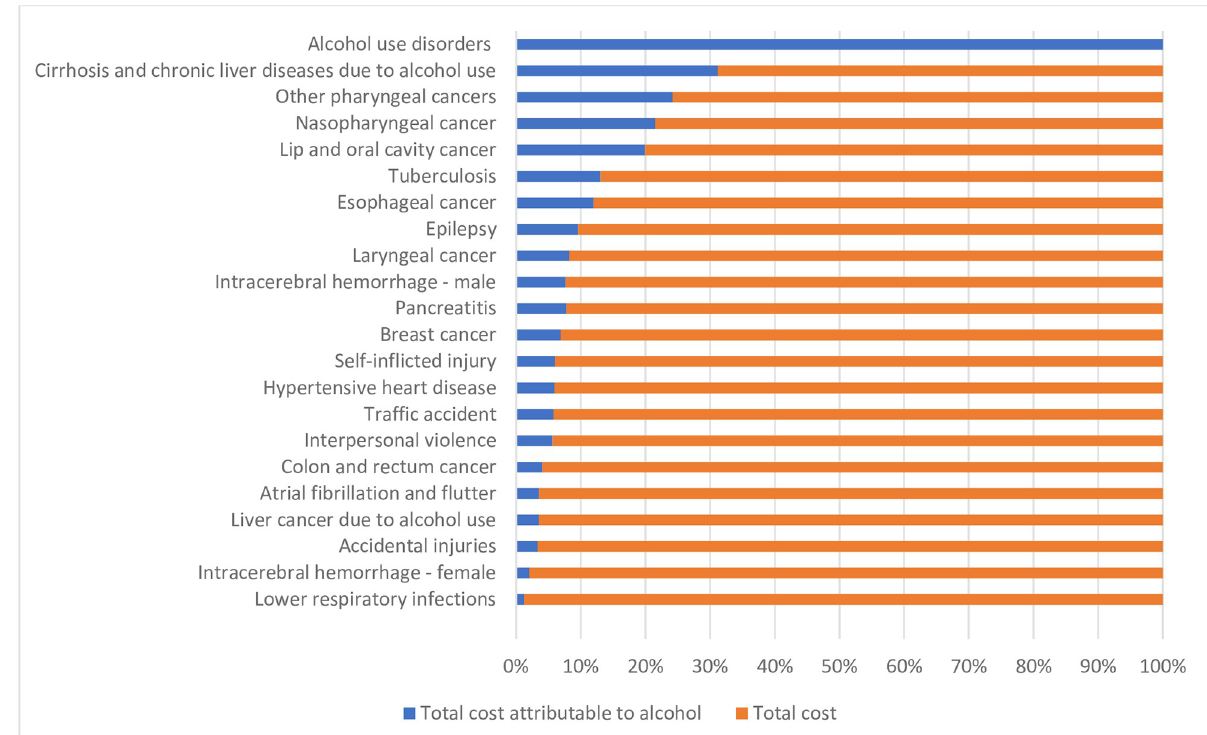
Fig 2. Proportion of total cost attributable to alcohol according to ICD-10, Brazil, 2010–2018.